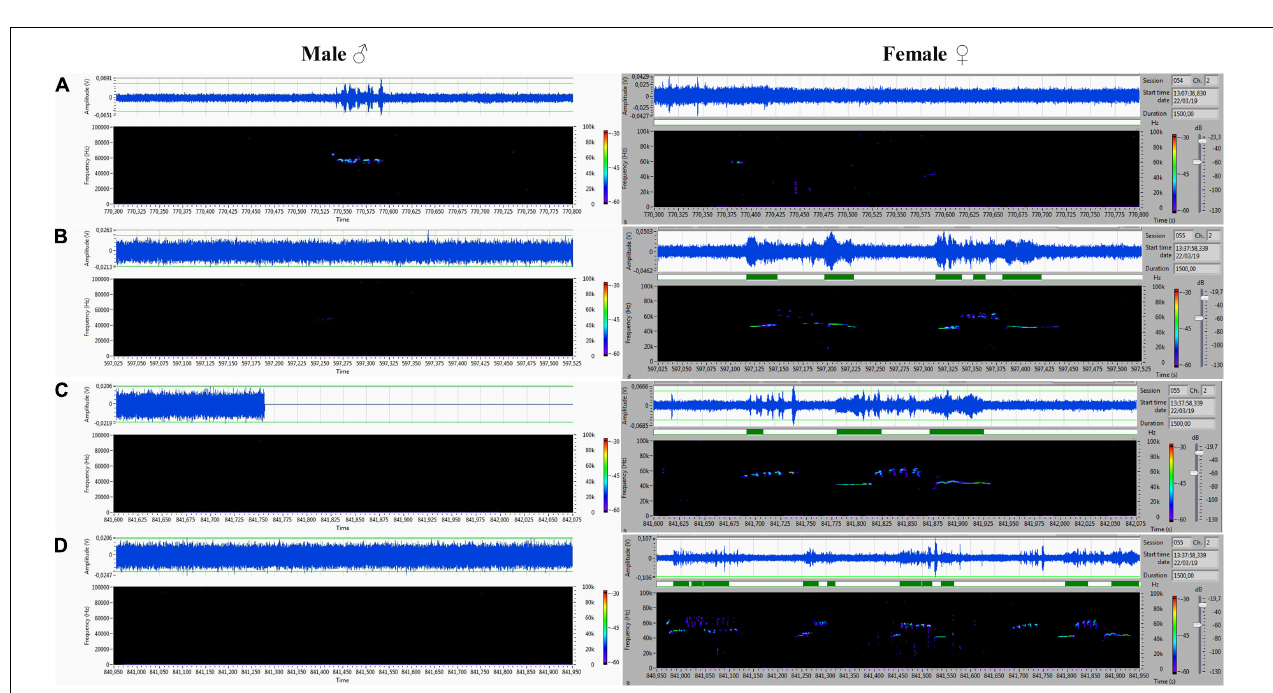
FIGURE 6 | (A,C) Different forms of 22-kHz specific for VOC-NCE: composite forms with different lengths of 22-kHz signal with co-occurring higher frequencies. (B) Short form of 22 kHz. All of them were emitted by males, and analogical parts of the female‘s spectrogram were blank.